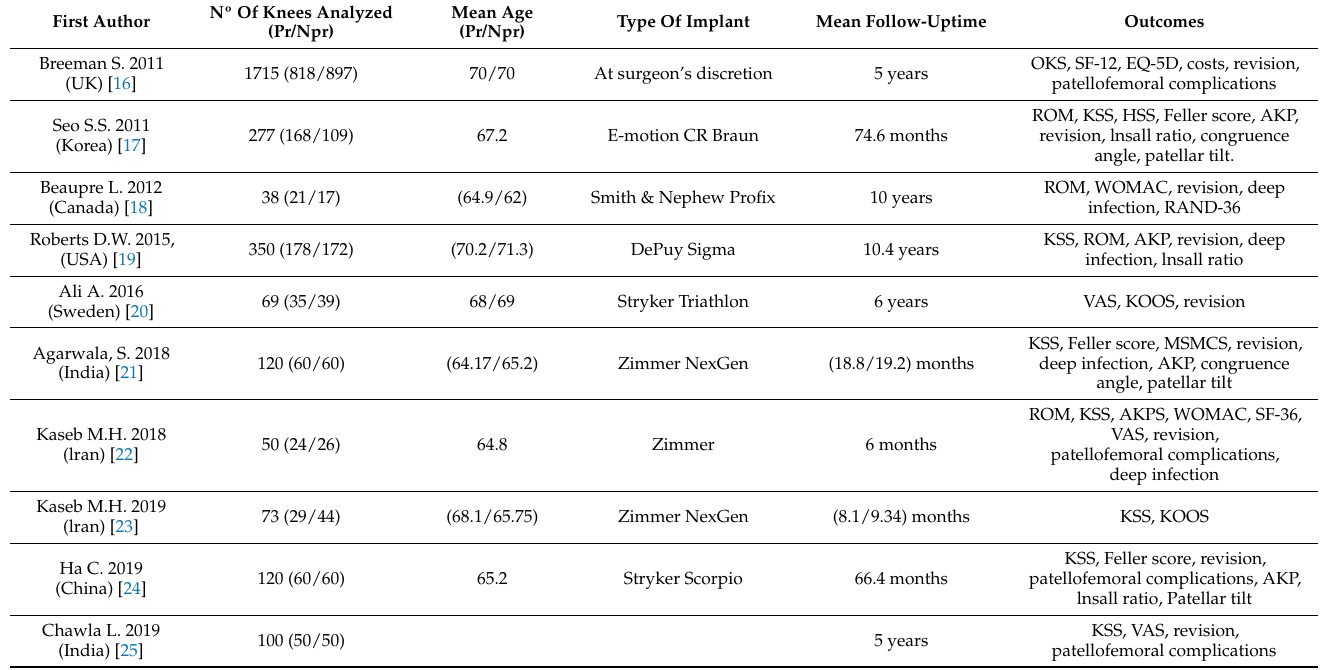
Table 1. Articles selected and included in the meta-analysis.